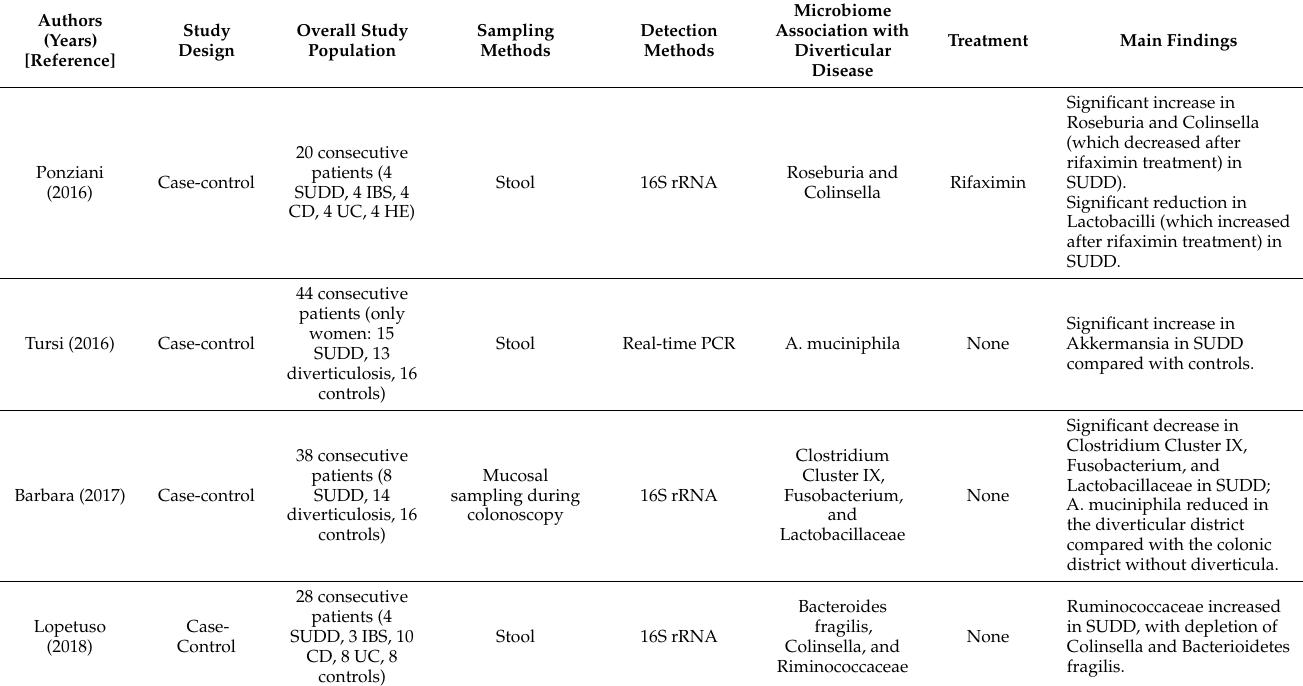
Table 2. Microbiota characterization in symptomatic uncomplicated diverticular disease